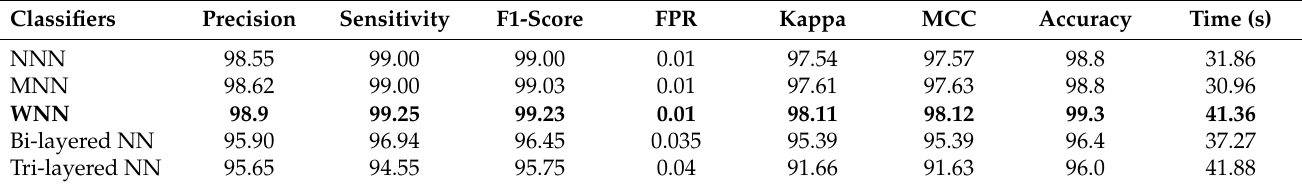
Table 7. Proposed fusion results on COVID-19 Lung CT Scans